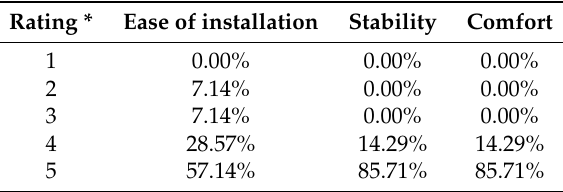
Table 5. LCs deployability and comfort survey results. Most respondents found the system easy to install and did not notice any problems with stability or the comfort of the